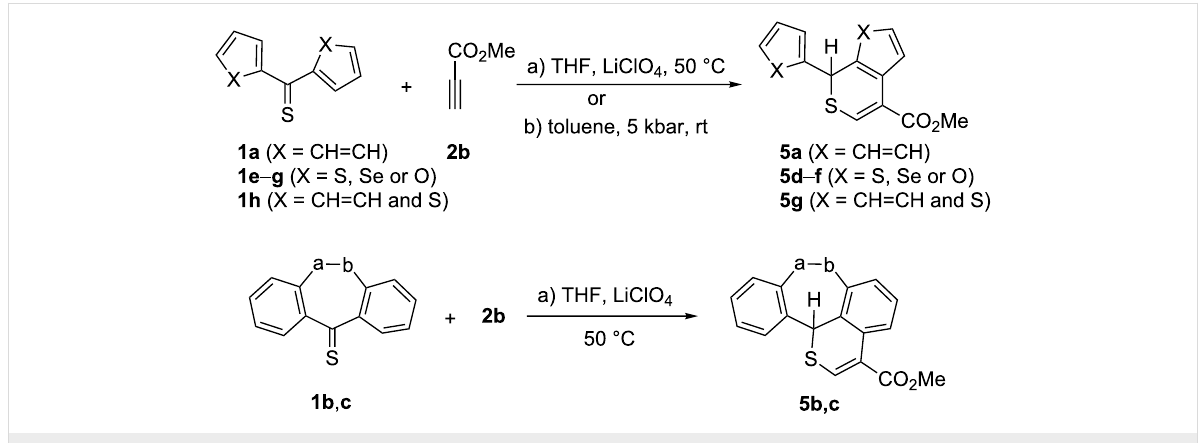
The analogous reactions of 2a with bis( N -methylpyrrol-2-yl) thioketone ( 1d ) afforded the pyrrolo[2,3- c ]thiopyran derivative 4d in modest yield (35%) (Scheme 2). In the case of bis(thien- 2-yl) thioketone ( 1e ), the reaction with 2a was carried out in toluene at room temperature under a pressure of 5 kbar. After 72 h, the corresponding thieno[2,3- c ]thiopyran 4e was obtained in 35% yield (Scheme